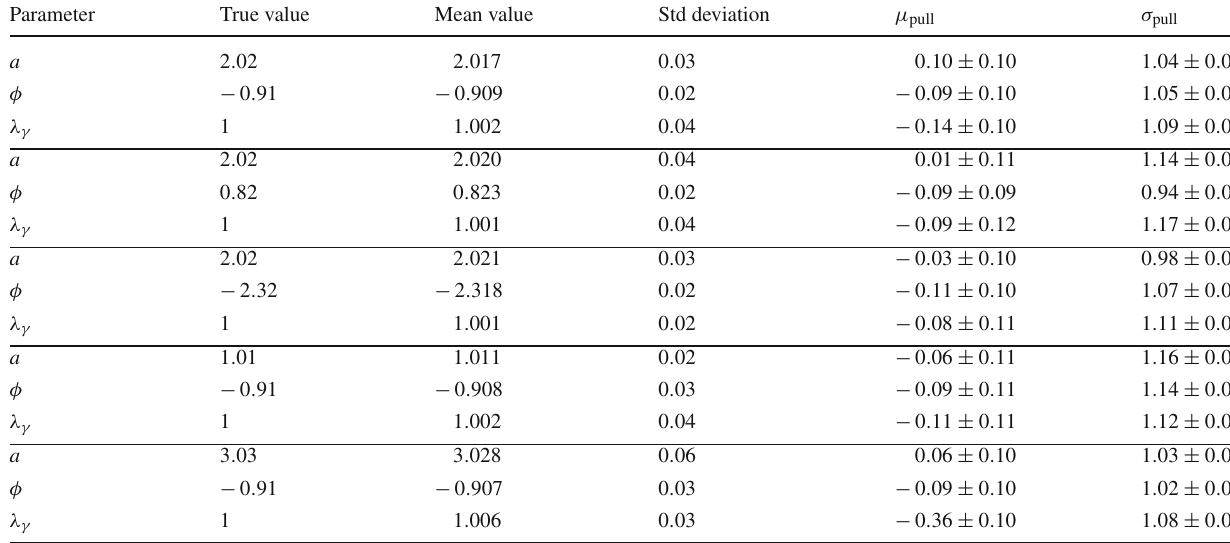
eters a and φ stand respectively for the relative magnitude and phase between the decay with K 1 ( 1270 ) + → K + ρ( 770 ) 0 and the decay